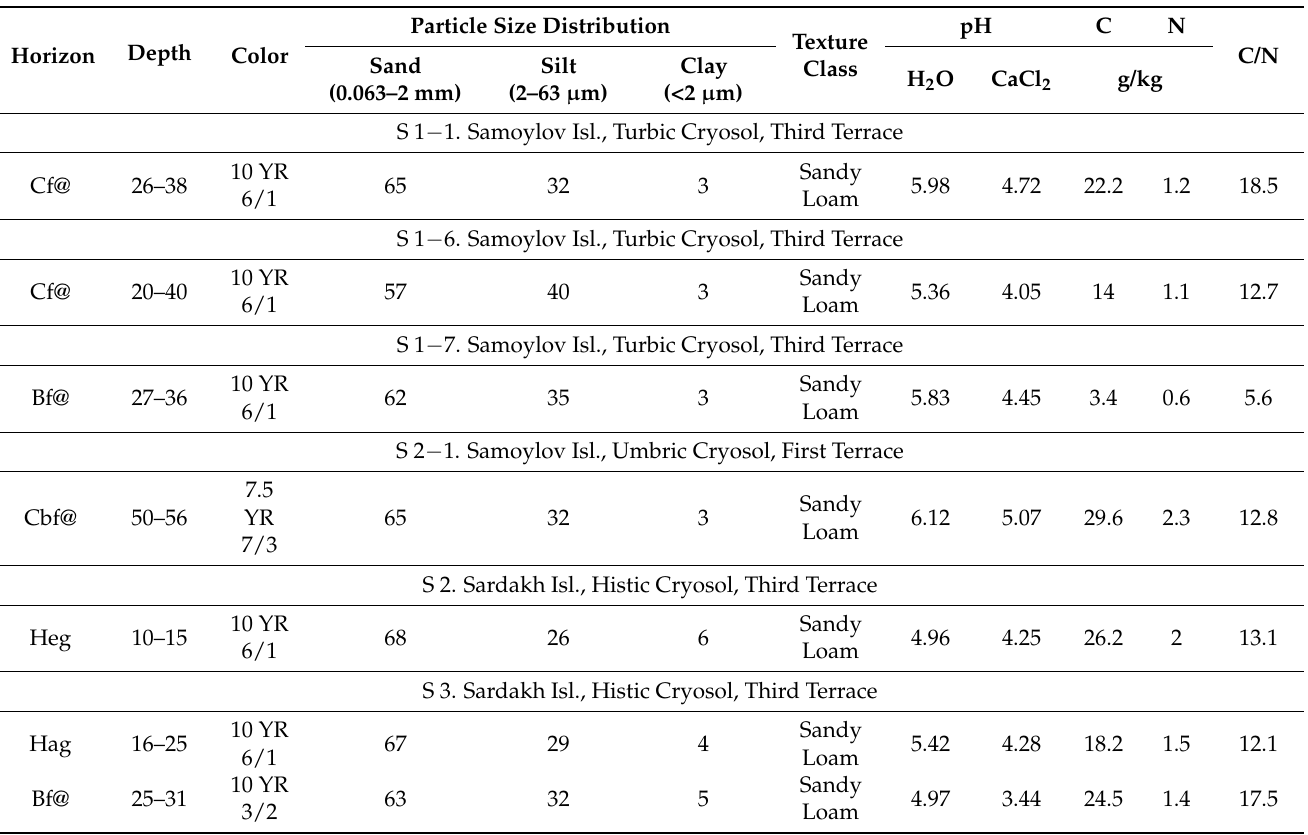
Table 3. Physico-Chemical Characteristic of Study